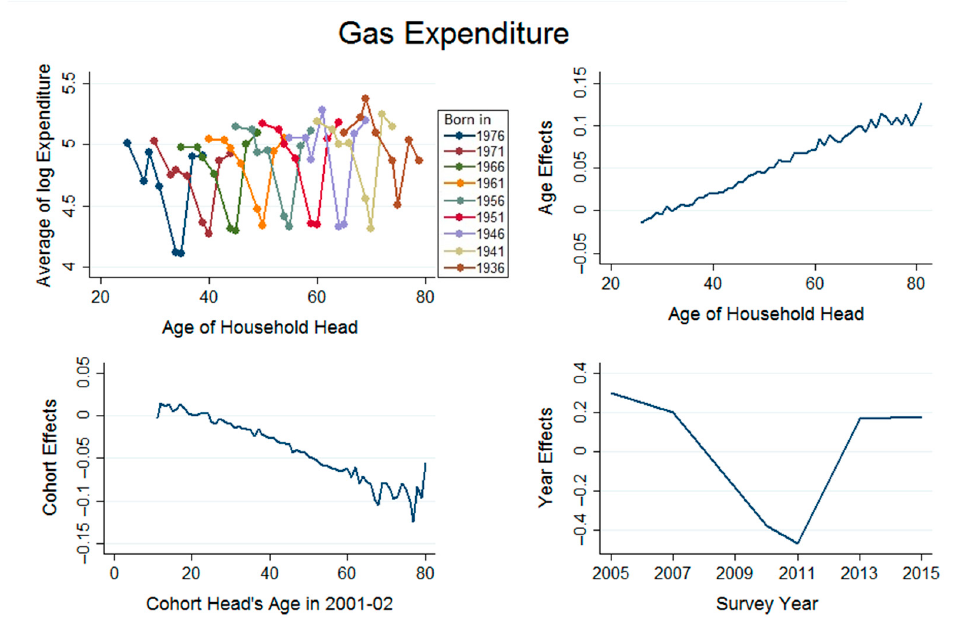
Figure 8. Gas Figure 8. Gas Expenditure. Figure 8. Gas Expenditure.